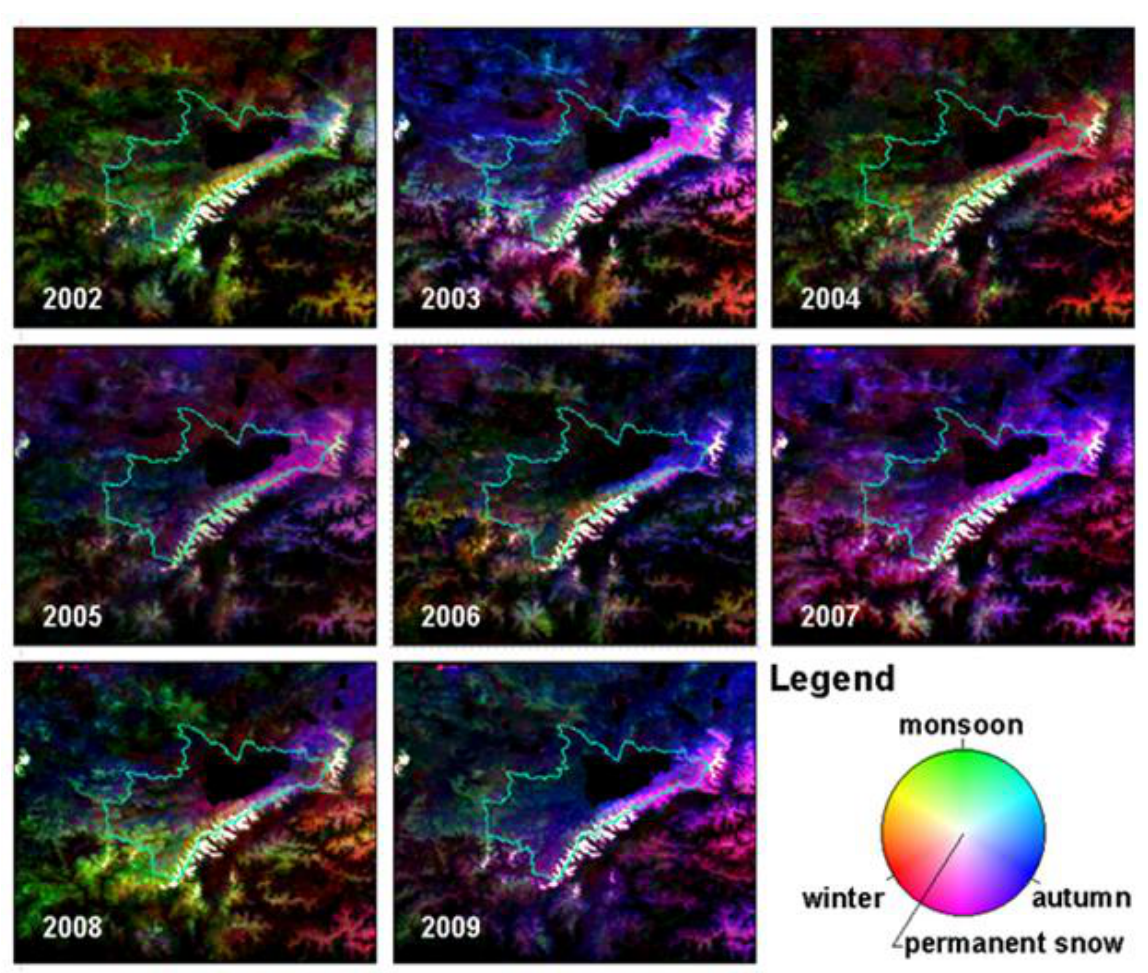
Figure 4. Time series of RGB syntheses of snow cover distribution (RSD) from MODIS/Terra snow data for Nam Co Basin in the central part of the Tibetan Plateau for the years 2002–2009. Nam Co Basin is marked by a cyan water